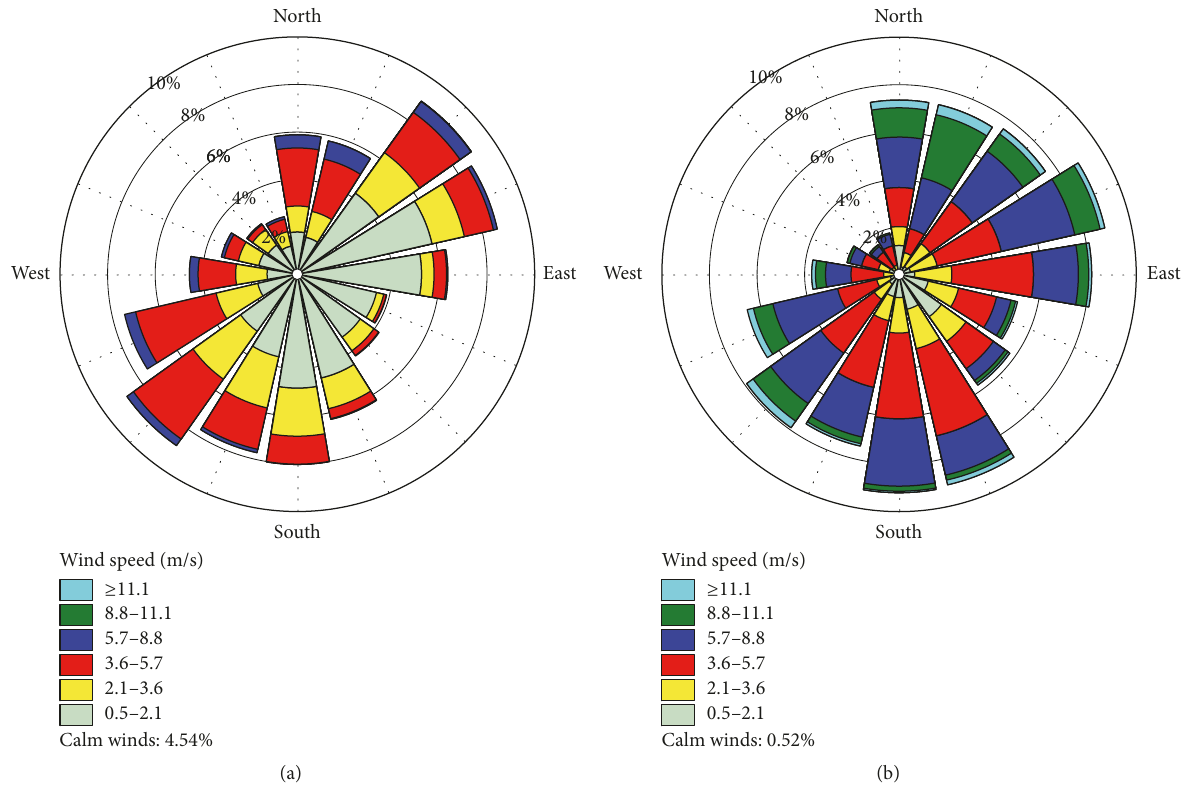
Figure 2: Wind rose in ULA at heights of 10 m (a) and 40 m